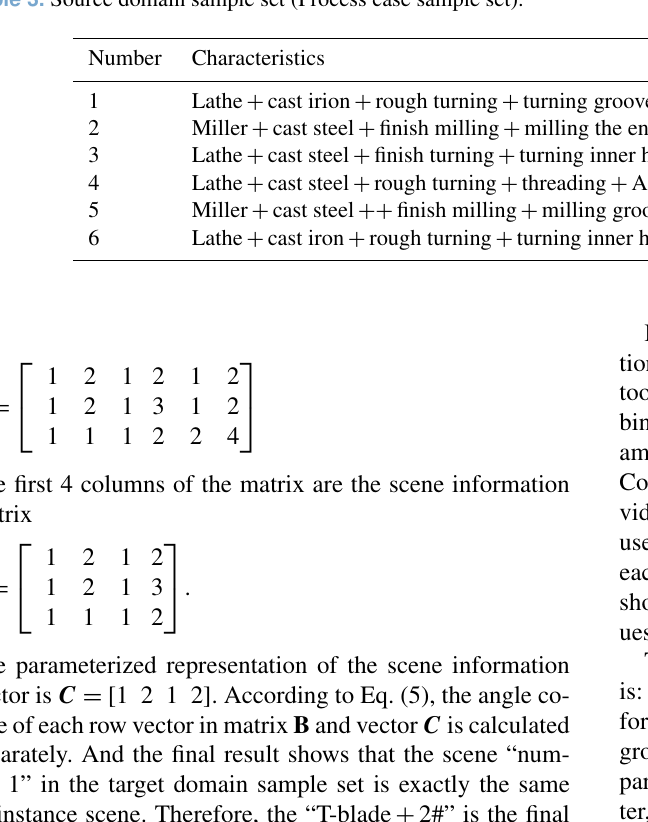
Table 3. Source domain sample set (Process case sample